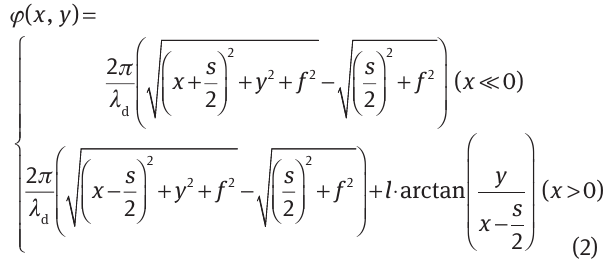
is the wavelength in free space, f is the focal where λ d length along the axial direction, l is the topological charge, and s is the distance between two foci. Figure 5A plots the phase profile of the dual-focal metasurface with a diameter of D = 50 μ m, a focal length of f = 60 μ m, the topological charge of l = 1, and the separation between the two foci of s = 20 μ m. Similarly, the corresponding meta-atoms are properly selected and arranged with a uniform rotation of 45 ° with respect to the x -axis after dis- cretizing the phase distribution on the x – y grid, as shown in Figure 5B. Figure 5C presents the SEM image of the fab- ricated dual-focal metasurface, where the spiral pattern can be clearly seen on the right side. Subsequently, the dual-focal sample was measured using the same setup, and the intensity distributions at the corresponding focal planes of different wavelengths are displayed in Figure 5D–I. Generally, two focal spots are formed with negligible backgrounds, indicating the excellent phase realization. The diffraction-limited focal spot on the left has a Gaussian-distributed intensity profile, while the right spot exhibits the intensity singularity with a minimum in the central part. When a linear polarizer ori- ented 90 ° with respect to the illumination polarization was placed in front of the CCD camera to filter out any co-polarized light, the intensity profiles remain largely unaffected and the moderate noise is removed, quali- fiedly indicating the high performance of our metasur- face design. Here, the non-negligible noise is most likely associated with the imperfections in fabrication and the gap between two sub-metasurfaces, leading to increased co-polarized